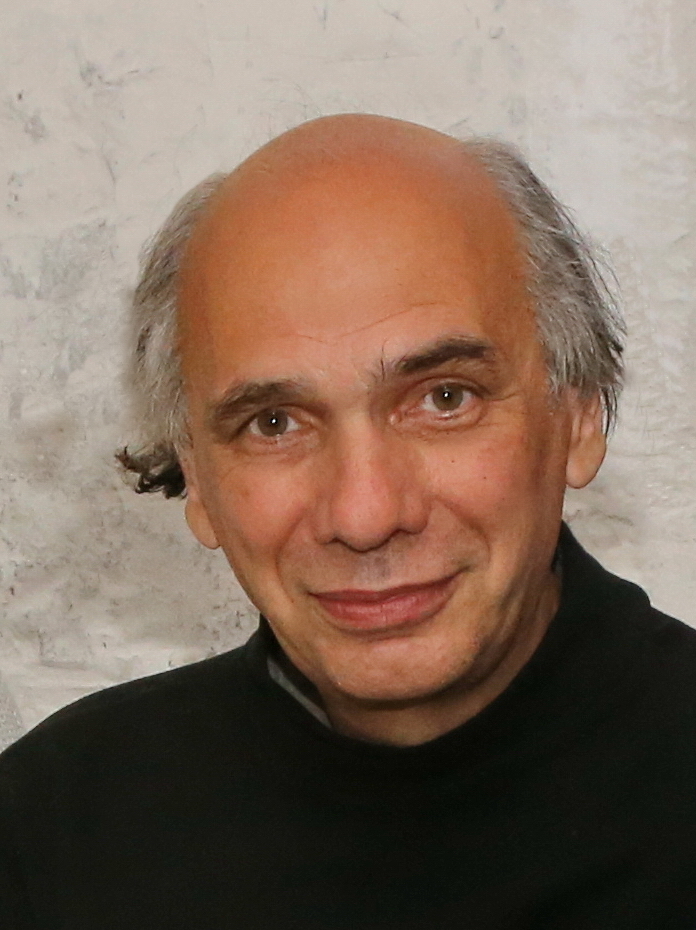
Yu.A. Nasimovich